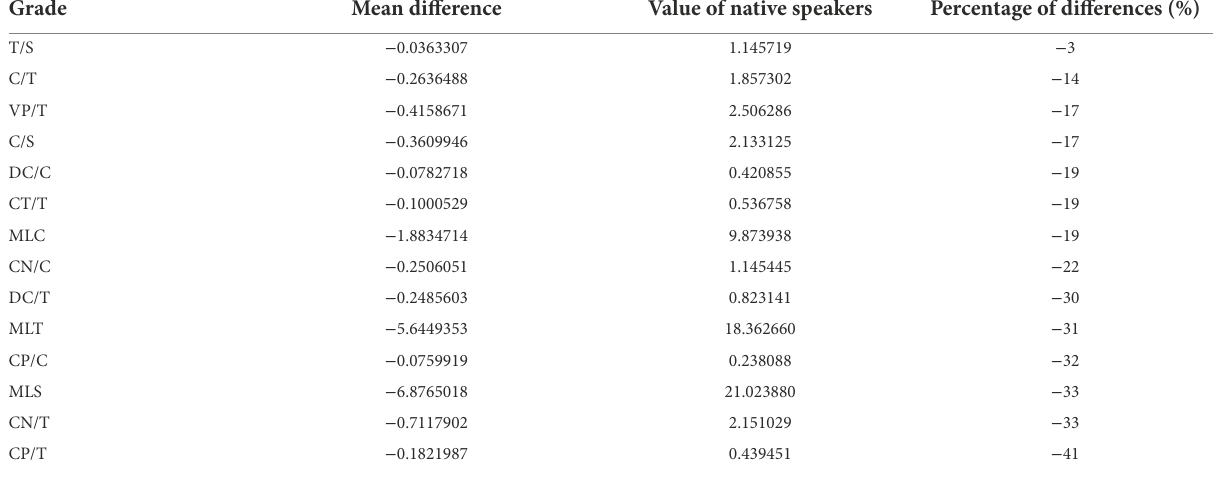
TABLE 6 Percentage of